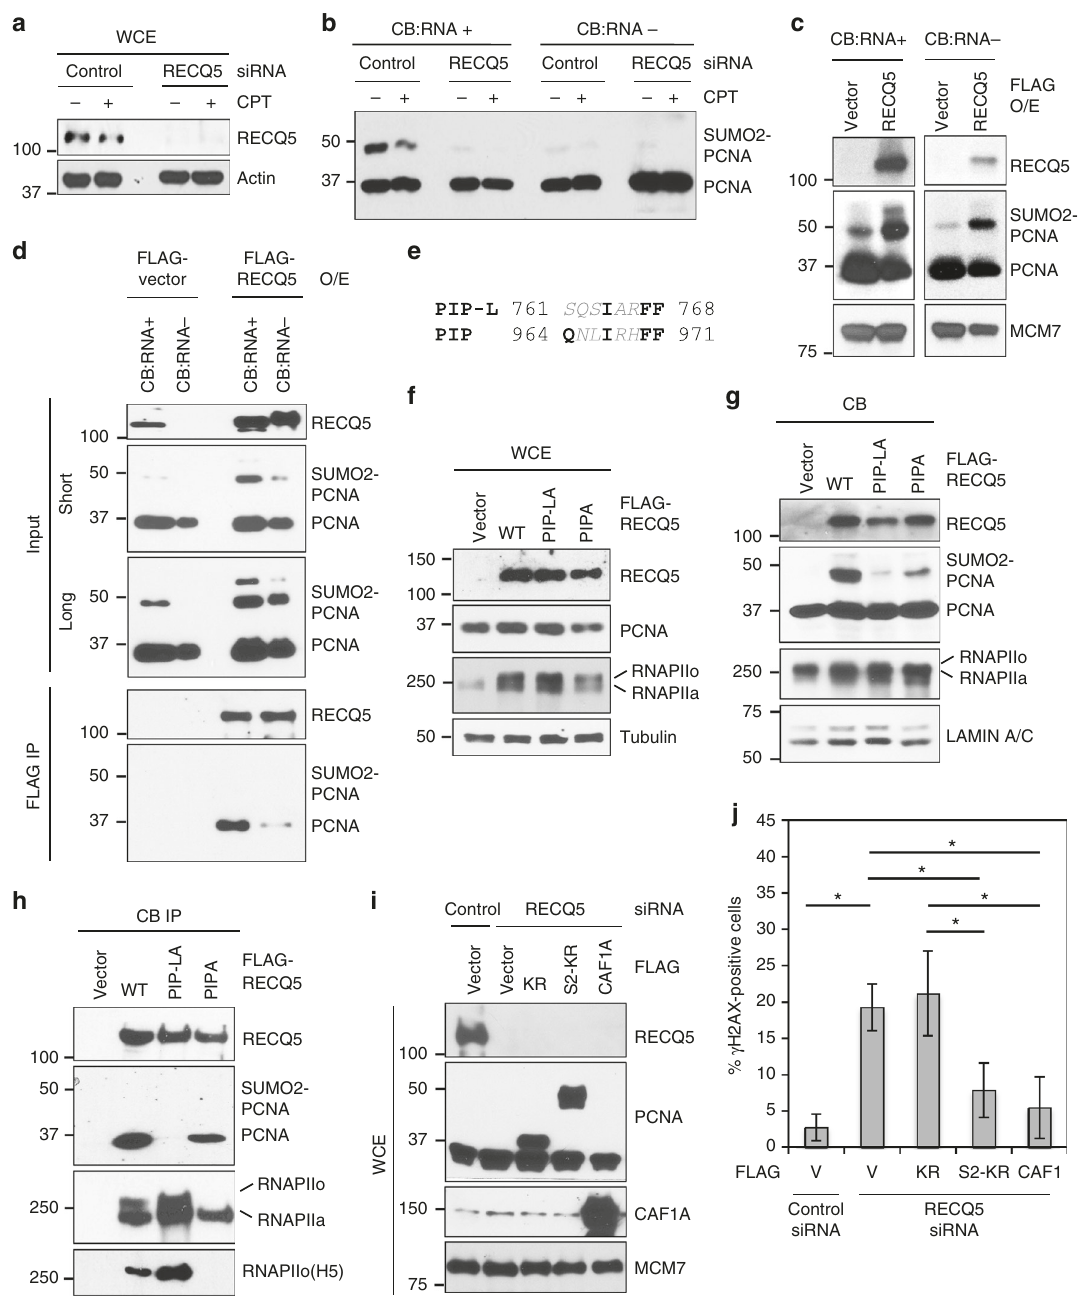
Fig. 7 RECQ5 promotes SUMO2 conjugation of PCNA. a Western blot analysis of RECQ5 in whole cell extracts (WCE) prepared from control or RECQ5 siRNA knockdown HEK293T cells treated with or without camptothecin (CPT, 5 µ M). Actin was used as a loading control. b Western blot analysis of PCNA in the CB:RNA + and CB:RNA − fractions prepared from HEK293T cells with or without CPT treatment from a . c Western blot analysis of the indicated proteins in CB:RNA + and CB:RNA − fractions prepared from HEK293T cells with or without exogenous overexpression of FLAG-RECQ5. MCM7 was used as a loading control. d Western blot analysis of the indicated proteins in the input of the CB:RNA + and CB:RNA − fractions with or without exogenous overexpression of FLAG-RECQ5 visualized with short and long exposure times (top) and in the FLAG-RECQ5 complex puri fi ed from the CB:RNA + and CB:RNA − fractions shown above (bottom). e Amino acid sequences of the PCNA-Interacting-Protein (PIP) and PIP-like (PIP-L) motifs found in human RECQ5 protein are shown in bold. f Western blot analysis of the indicated proteins in WCE prepared from HEK293T cells with or without exogenous overexpression of FLAG-RECQ5 WT and mutant proteins. g Western blot analysis of the indicated proteins in the chromatin-bound (CB) fractions prepared from HEK293T cells from f . h Western blot analysis of the indicated proteins in the FLAG-RECQ5 complexes puri fi ed from CB fractions shown in g . i Western blot analysis of the indicated proteins in WCE prepared from control or RECQ5 siRNA knockdown HEK293T cells with exogenous overexpression of indicated FLAG-tagged PCNA constructs or CAF1 or treated with an empty vector (V). j Quanti fi cation of γ H2AX-positive cells indicated in i . Each value in the graph represents the average value ± standard deviation ( n > 200) per one representative experiment. Only cells with 5 or more γ H2AX foci were counted as positive cells. p values equal to or less than 0.05 are indicated with an asterisk (*).The result was reproduced in